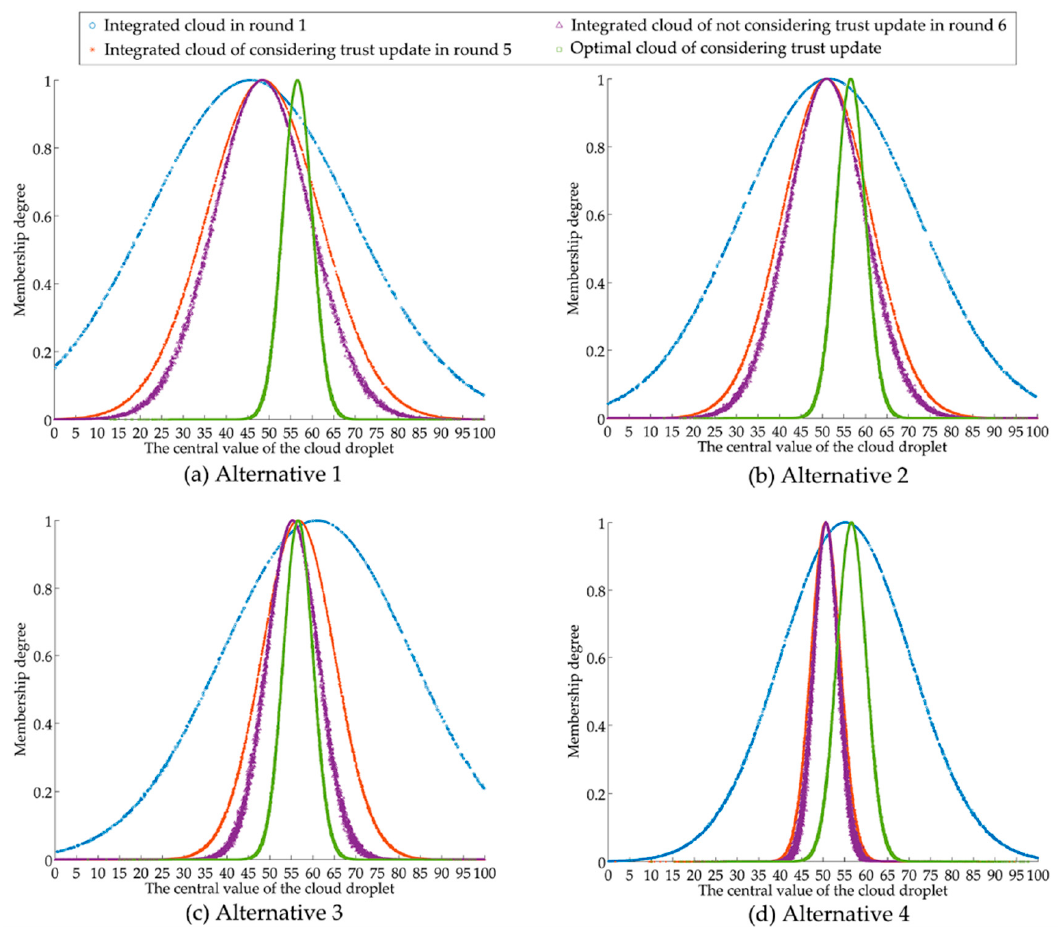
Figure 9. Integrated cloud of alternatives at each opinion interaction stage.